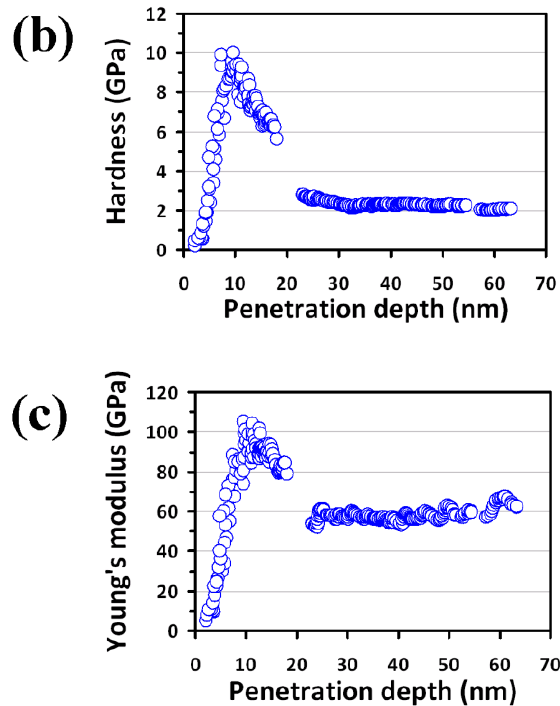
Figure 3. ( a ) A load-displacement curve showing the multiple “pop-ins” during loading part, ( b ) hardness-displacement curve and, ( c ) Young’s modulus-displacement curve are obtained from the nanoindentation continuous contact stiffness (CSM) results of Bi 2 Se 3 thin film.